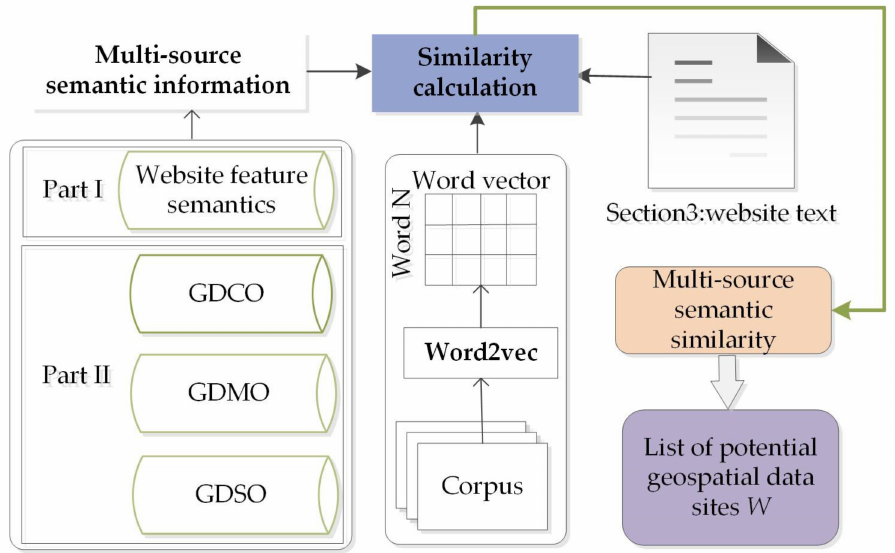
Figure 4. Flow chart of website filtering based on multi-source semantic